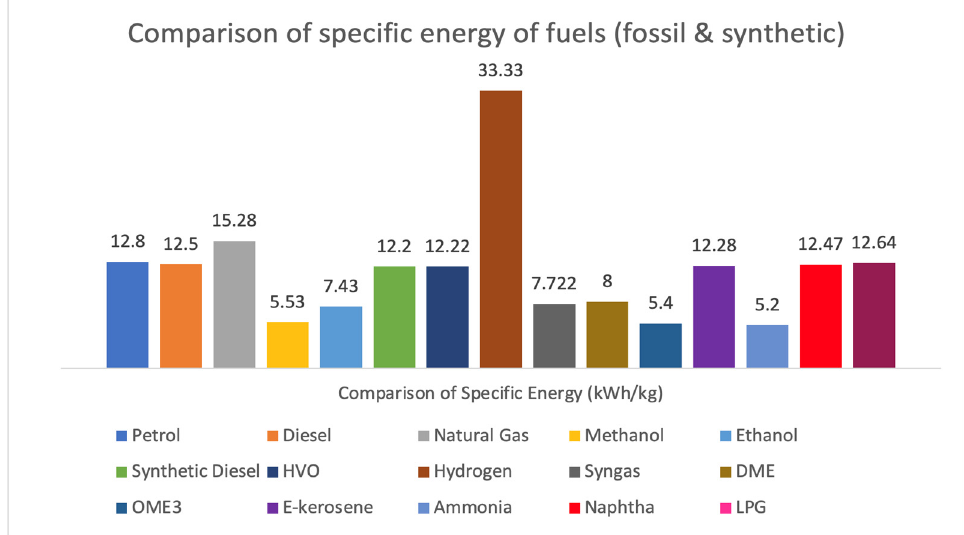
Figure 19. Fuel comparison chart.